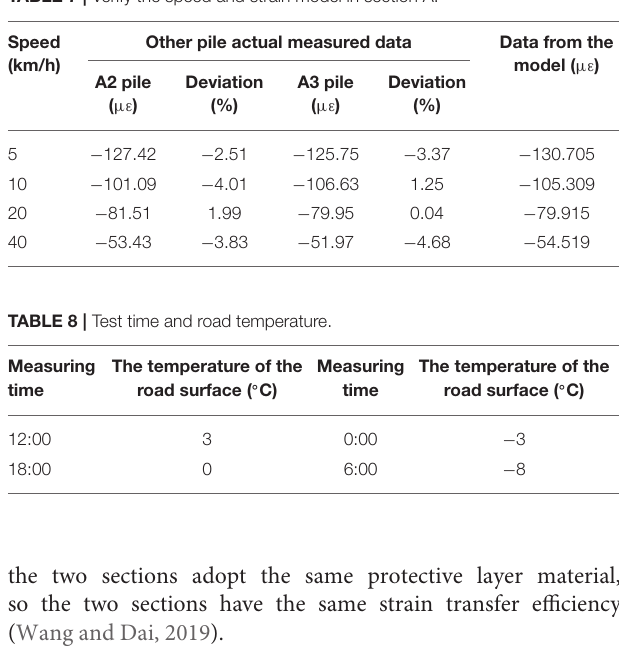
TABLE 7 | Verify the speed and strain model in section A.